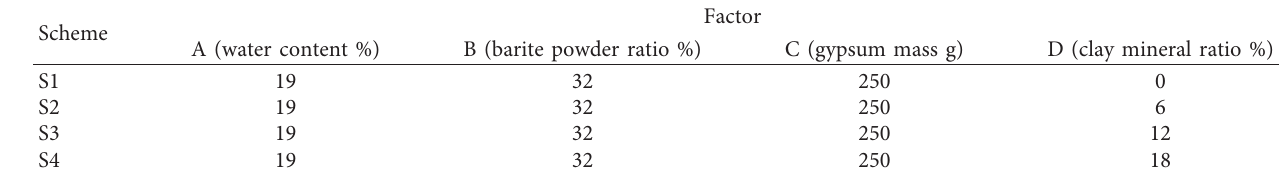
Table 5: Secondary refinement test scheme of similar materials.